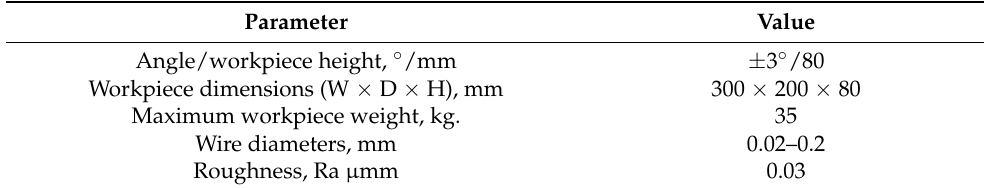
Table 2. Technical specification of the electroerosive cut-out machine Agie Charmilles CUT 1000